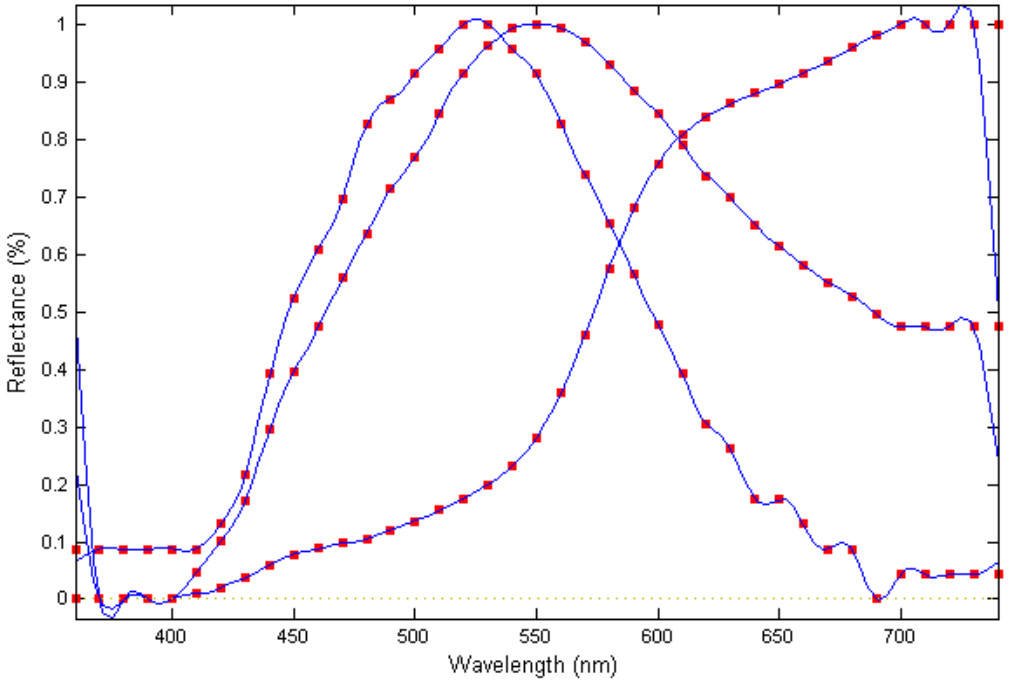
Figure 2. Reflectance curves resulting from the smoothing process for three granite specimens. Reflectance values are indicated as red